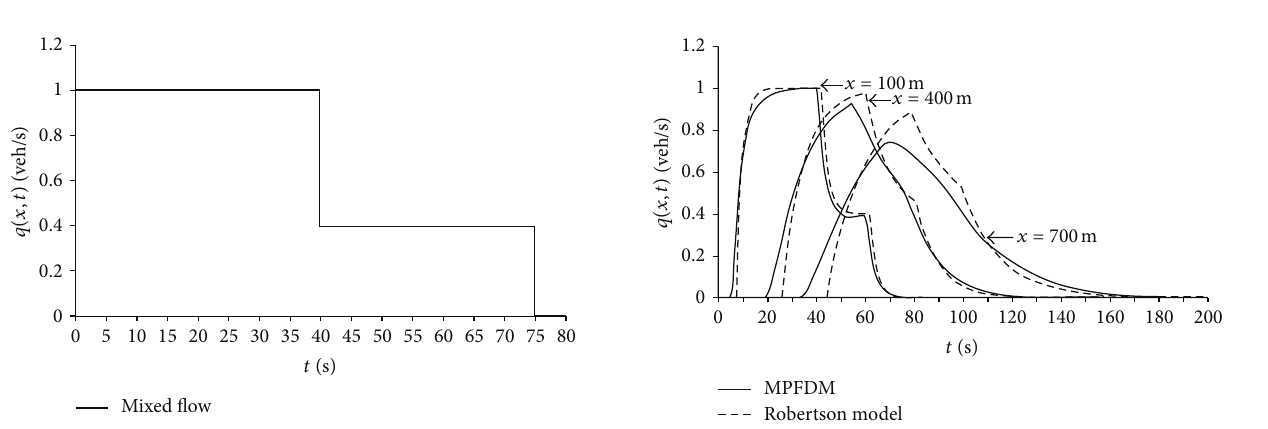
Figure 3: Departing flow distribution at upstream intersection. Figure 4: Comparison of arriving flow distribution between the proposed model and the Robertson